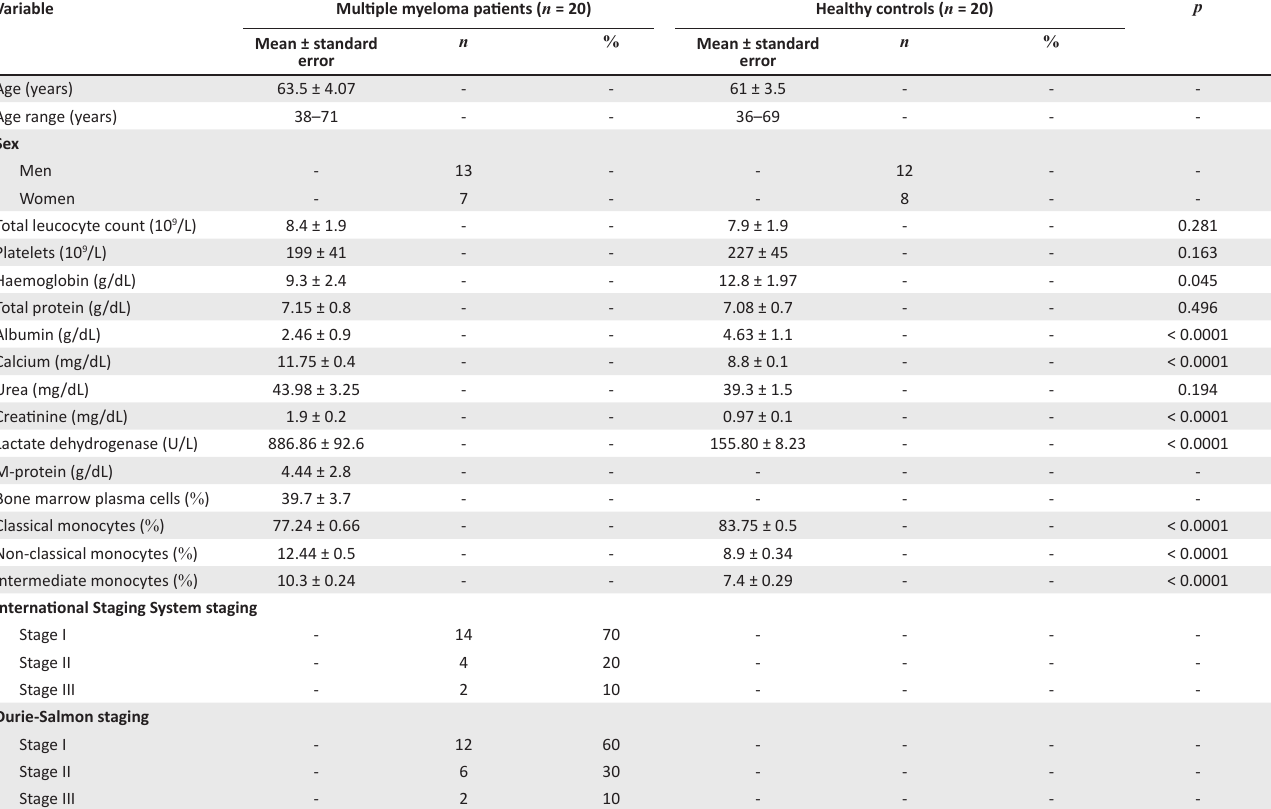
TABLE 1: Baseline characteristics of studied newly diagnosed multiple myeloma patients and healthy controls, Assiut, Egypt, October 2018 – August 2019.